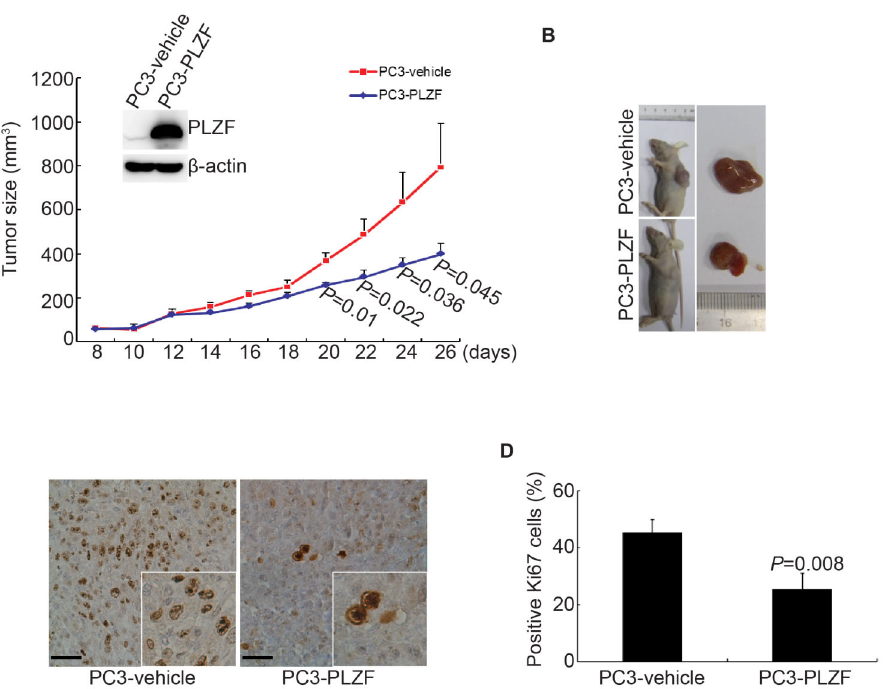
Figure 6. PLZF inhibits the tumor growth in nude mice. A. The tumor volumes (six mice for each group) were measured at the indicated times, shown as the means with bars as SD. The P values for comparison were gotten by Student’s t -test. The inserted western blots showed PLZF expression. B. Representative macroscopic images for tumors 26 days after subcutaneous injection. C. Representative immunohistochemistry staining of Ki67 (scale bar, 50 m m) for PLZF-expressing and empty vector-carrying tumors. The representative images were recorded under a 40 6 objective. D. The statistical analysis of the accounts of the Ki67 positive cells was displayed on the right panel, shown as the means with bar as SD. The P values for comparison were gotten by Student’s t -test.